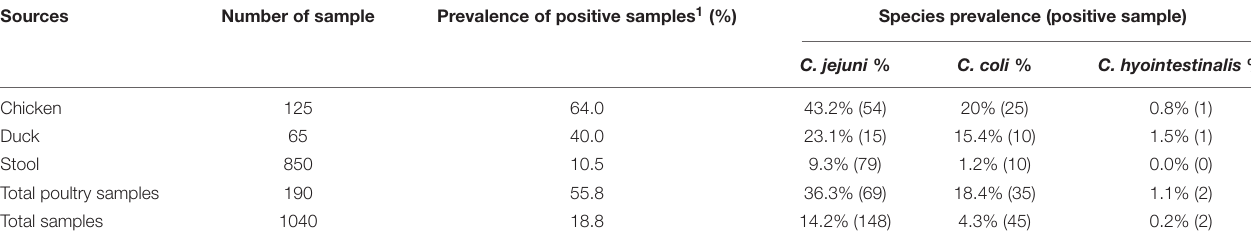
TABLE 1 | Occurrence of Campylobacter species in poultry and clinical samples in Southeastern China.